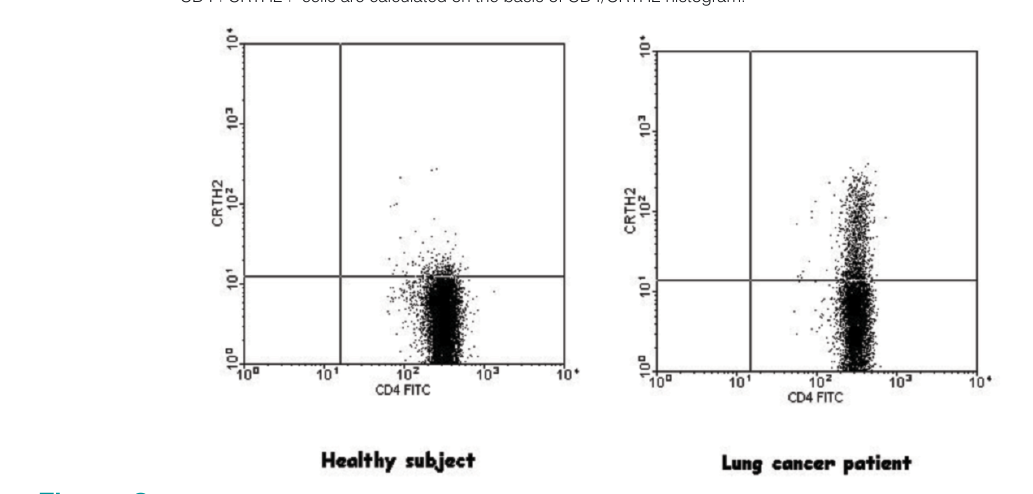
Figure 2. Survival curve of High CRTH2 and Low CRTH2 Groups in non-small cell lung cancer. Cox regresion analysis did not show that CRTH2 ekspression of CD4 + T cells associated with survival data.